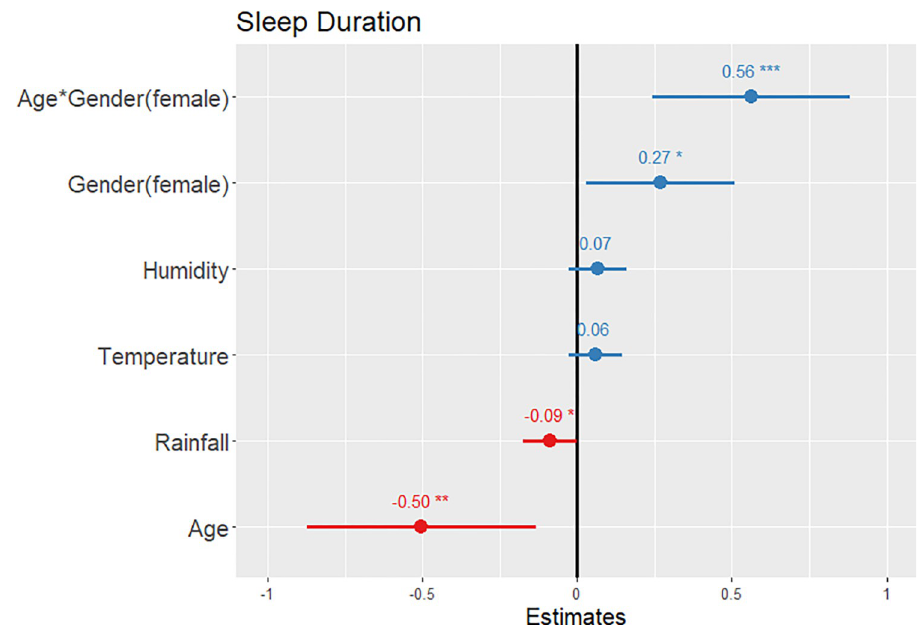
Fig 2. A prediction plot of standardized fixed effects for sleep duration. Longer sleep duration is predicted by the interaction of age and gender, gender, and negatively predicted by age and rainfall. Significance codes: � p < 0.05; �� p < 0.01; ��� p < 0.001.